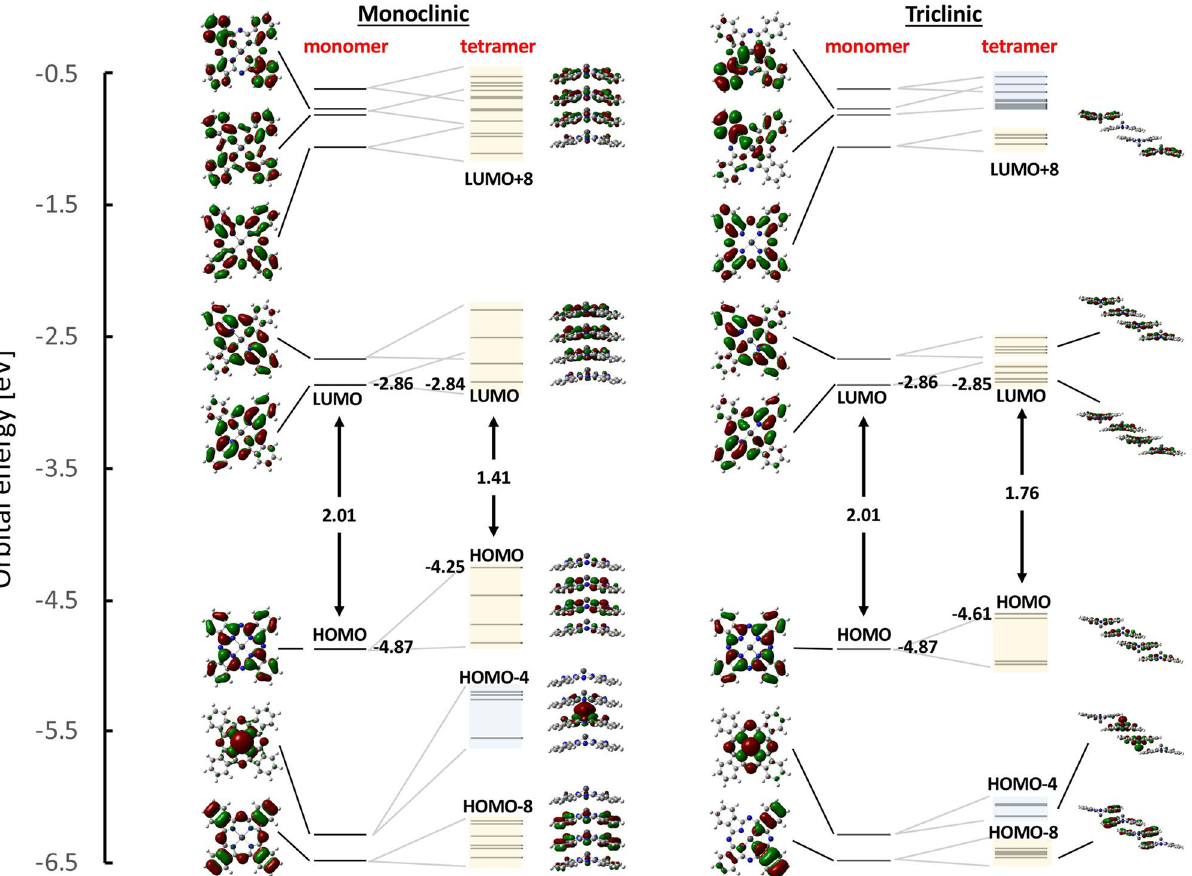
Figure 4. Energy diagram and wavefunctions of the corresponding molecular orbitals (MOs) for the monoclinic and triclinic tetramer models. Here, the bands indicated by light yellow and light blue colours denote p- and d-orbital-based bands, respectively. The HOMO and LUMO are abbreviated expressions of the highest occupied and the lowest unoccupied MOs, proposed by Gouterman and his coworkers 17–19 . Here, the HOMO and LUMO are the abbreviated expressions of the highest occupied and the lowest unoccupied molecular orbitals, respectively. Since Table S1 (Supplementary) shows that the Q-band excitation wavelength (HOMO → LUMO/LUMO + 1) for the PbPc molecule in solvent (methanol) was redshifted by ca. 20 nm when compared to that for the molecule in the gas phase, a compari- son between the experimental (c, d) and theoretical (e) spectra in the Q-band suggests that the intense peak at approximately 700 nm for the monomer (d) corresponds to the most intense peak of the Q-band at approximately 740 nm for the films (c). In a similar manner, a comparison between Fig. 3a and b spectra indicates that the peak at approximately 340 nm for the isolated PbPc monomer (b) corresponds to the most intense peak of the Soret band at approximately 350 nm for the PbPc films (a). These peak shifts are due to the dielectric constant of surrounding molecules (solvent effects) 20 . Thus, these results imply that an amorphous phase, which resembles the state of isolated PbPc molecules, exists in each PbPc film (an amorphous phase cannot appear in the XRD pattern shown in Fig. 2). Accordingly, it is found from the results of Figs. 2 and 3 that the 10 nm- and 20 nm-thick PbPc films consist of amorphous and monoclinic phases, whereas the 40 nm-thick film consists of amorphous, monoclinic, and triclinic phases (the upper 20 nm-thick layer dominantly consists of the amorphous/triclinic phases, whereas the lower 20 nm-thick layer dominantly consists of the amorphous/monoclinic phases). We next discuss the changes in the Q-band spectral shape with respect to the film thickness (Fig. 3c) by comparison with theoretical results to solve the conflict on the assignment of the visible and NIR absorption bands between the experimental 5,12 and theoretical 13 results reported previously. Figure 4 shows the energy diagram of individual molecular orbitals (MOs) and their corresponding typical wavefunctions for the PbPc monoclinic (left) and triclinic (right) tetramers, along with those for the monomer (all MO wavefunctions are shown in Figs. S1–S3). Here, the bands indicated by light yellow and light blue colours denote the p- and d-orbital-based bands, respectively. As shown in Fig. 4, the HOMO–LUMO gap (1.41 eV) of the monoclinic tetramer becomes much narrower than that (1.76 eV) of the triclinic tetramer when compared to that (2.01 eV) of the monomer. Since the monoclinic phase has a more packed structure than the triclinic phase, the p-bands (and d-band) of the monoclinic tetramer become wider than those of the triclinic tetramer, thus reducing the HOMO (p-band)–LUMO (p-band) gap more significantly than for the triclinic phase. Actually, the electronic